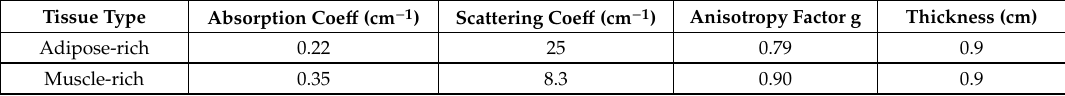
Table 1. The geometry and optical properties of the ex vivo tissue used in the Monte Carlo simulation.